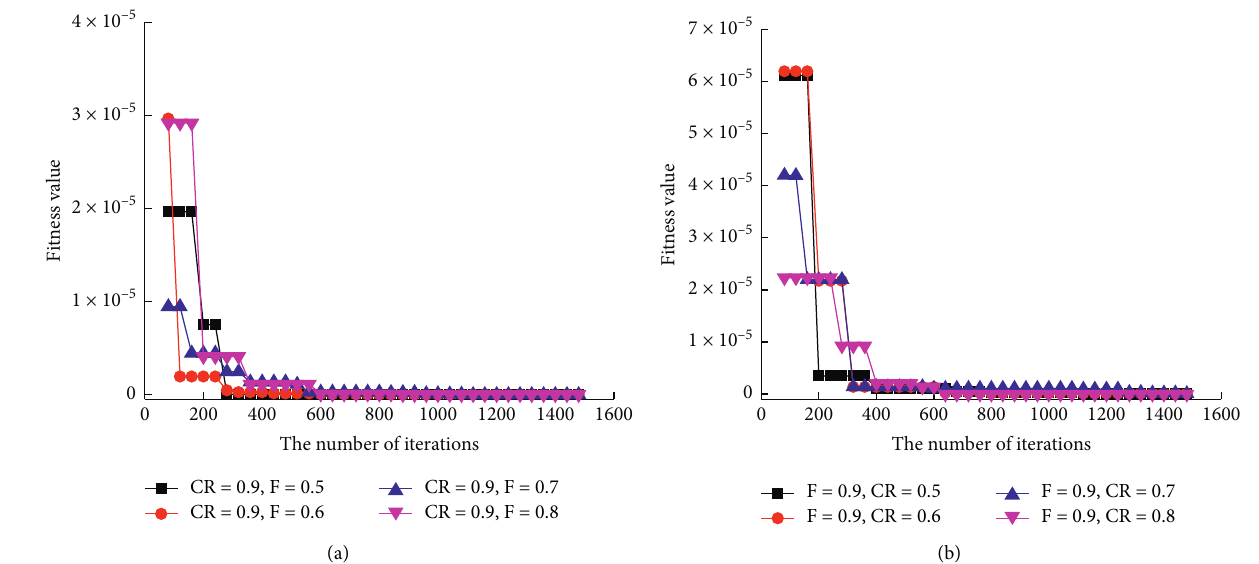
Figure 7: Iterative curves of different variation factors and crossover factors. (a) CR � 0.9 and F � 0.5 ∼ 0.8. (b) F � 0.9 and CR � 0.5 ∼ 0.8. Table 1: Results of back analyzed parameters. Damage parameters c r /kPa ζ κ Inversion results 60.121 0.6844